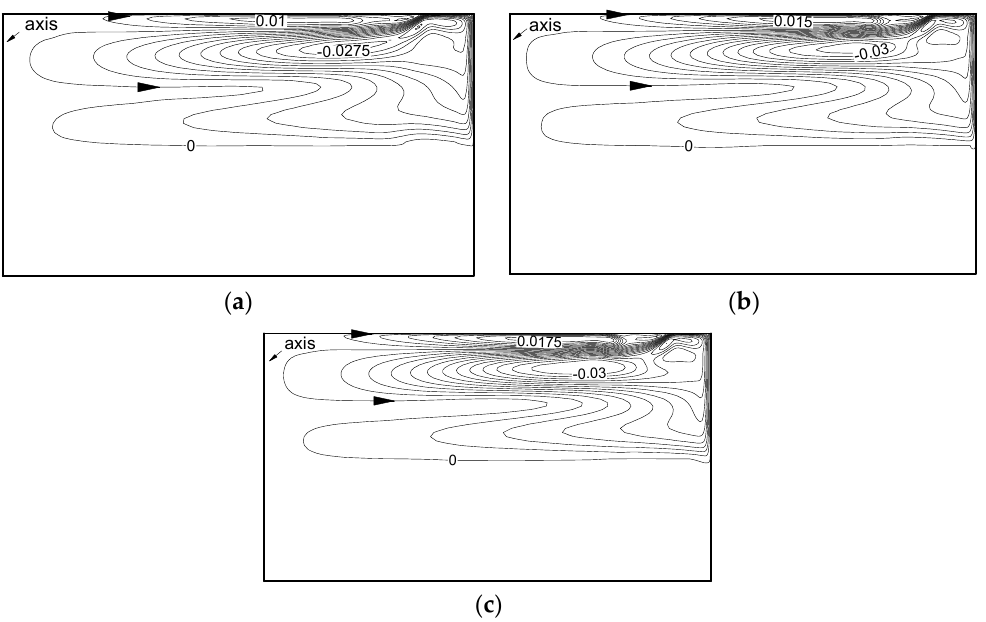
Figure 3. Stream function (unit: kg/s) of the silicon melt at S.F. = 50%: ( a ) 10 L/min, ( b ) 30 L/min, ( c ) 50 L/min.